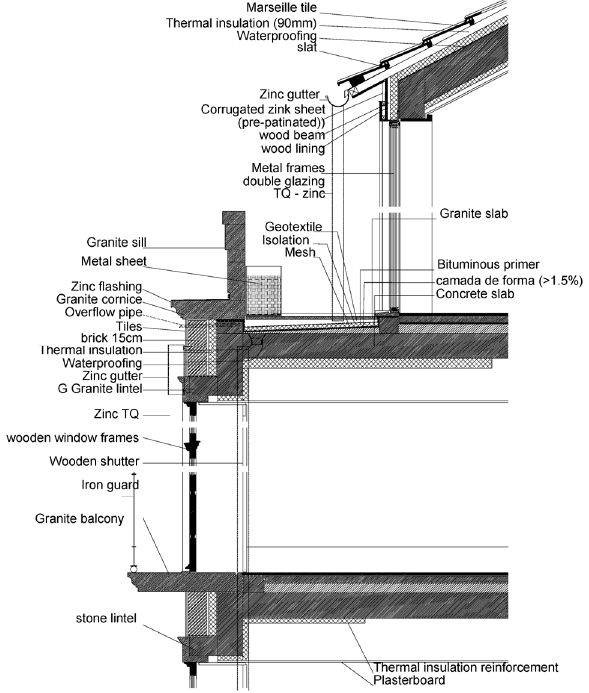
Figure 27. Braga. Constructive section (old building).